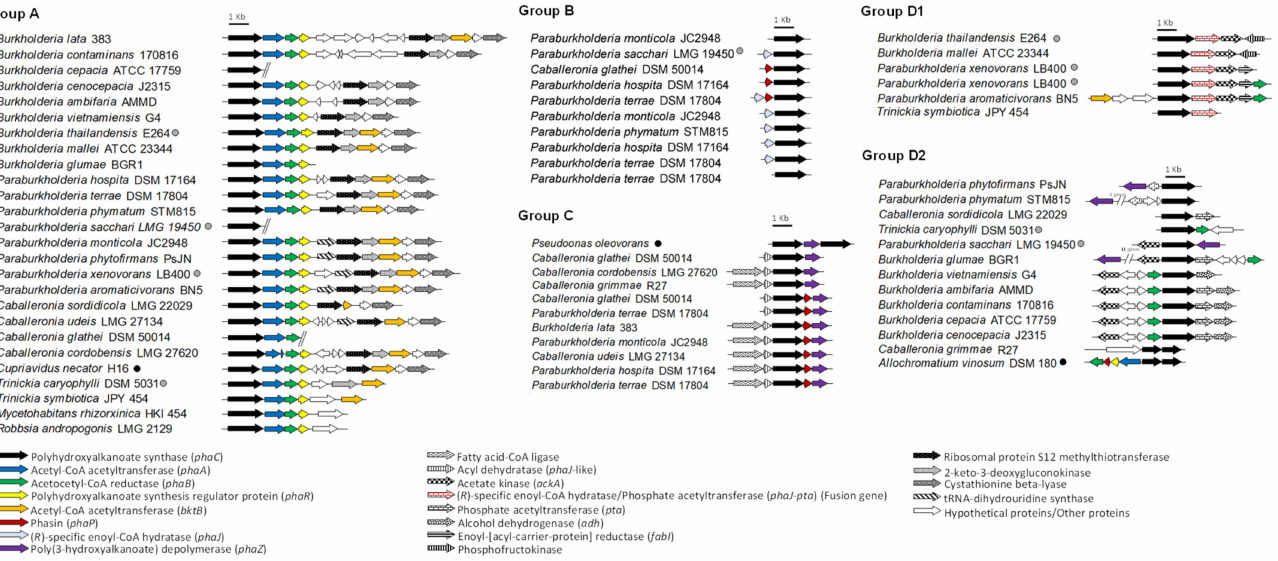
Figure 7. Gene contexts related to phaC gene of representative bacteria of the Burkholderia sensu lato group. PhaC homologous of C. necator H16 and pha gene clusters in which the phaC gene is present. Gene contexts are arranged according to the neighbor-joining phylogeny of their PhaC amino acidic sequence shown in Figure S1. Branches tagged with black dots indicate sequences with confirmed functionality not belonging to Burkholderia s.l. genera that have been incorporated for additional phylogenetic comparisons, while gray dots indicate Burkholderia s.l. species with reported polyhydroxyalkanoate synthesis. The phaC genes are in black. The function of the genes included in the clusters are indicated at the bottom. The sizes of genes are at a scale depicted in the 1 kb black bar above each group